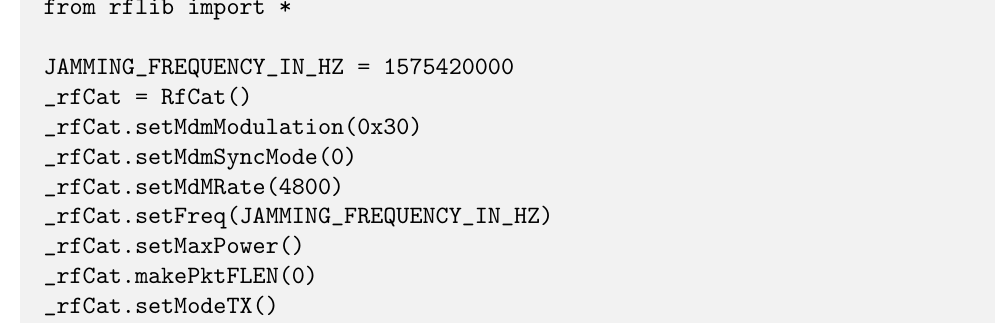
Figure 8. RFlib is used to jam a predefined frequency, here 1575.42